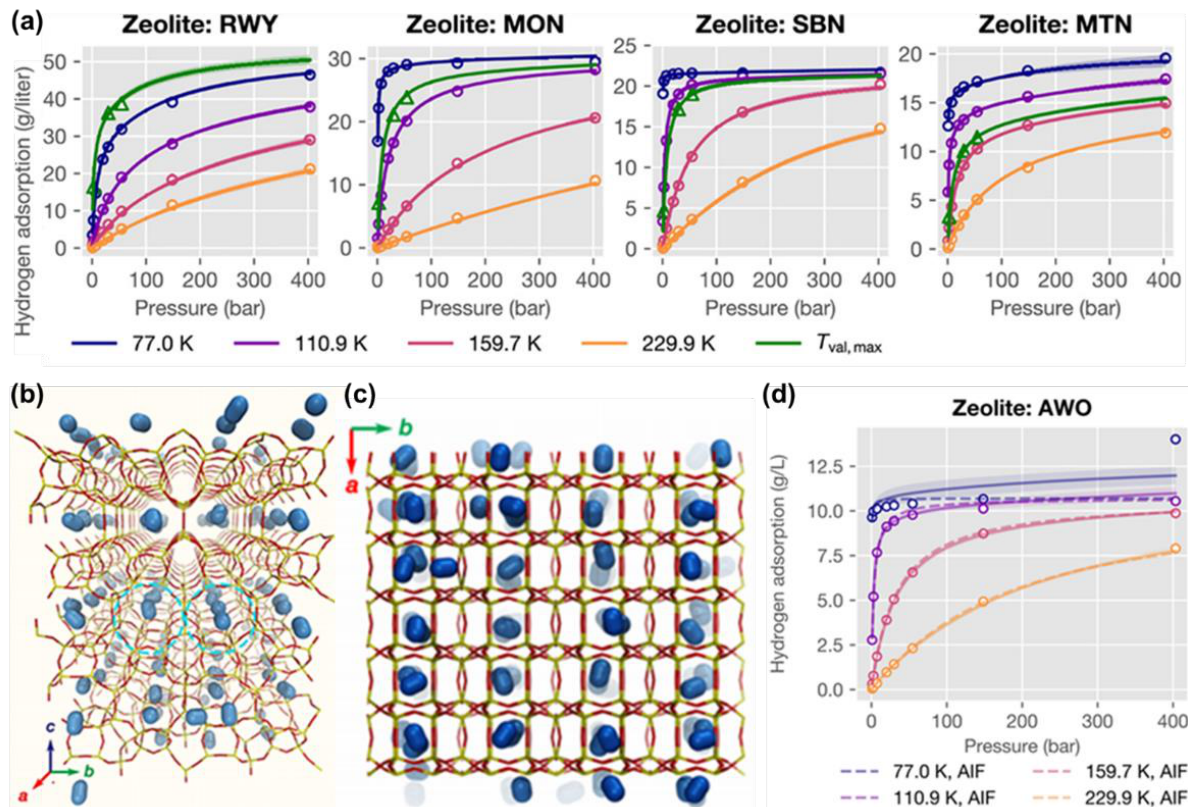
Figure 4. ( a ) Hydrogen adsorption behaviors of various types of zeolites, ( b , c ) 3D illustrations for hydrogen adsorbed in AWO-type zeolite, and ( d ) hydrogen adsorption isotherms of AWO-zeolite. Reproduced from ref. [47]; copyright (2021) with permission from AAAS.